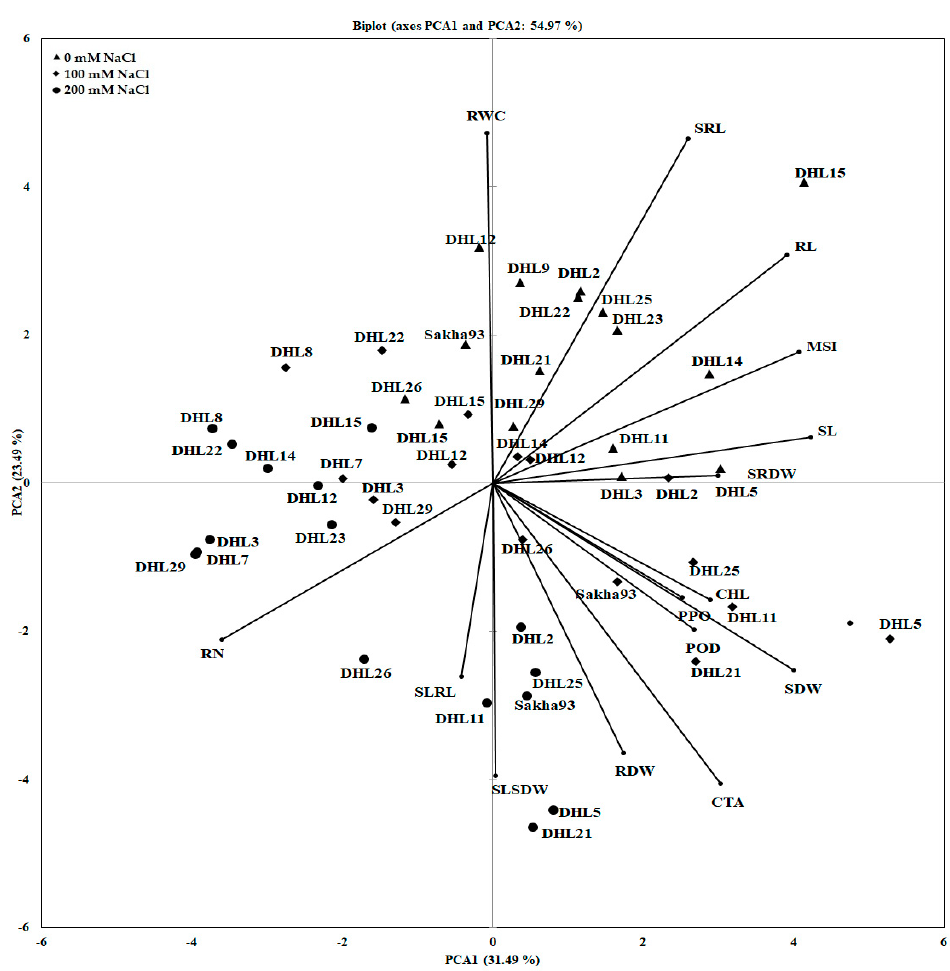
Figure 1. Principal components analysis (based on correlation matrix) of 16 wheat genotypes at three salinity levels. Biplot vectors are trait factor loadings for PC1 and PC2 of 15 measured traits. Doubled haploid line (DHL), roots number (RN), root length (RL), root dry weight (RDW), shoot length (SL), shoot dry weight (SDW), shoot root length ratio (SLRL), shoot root dry weight ratio (SRDW), shoot length shoot dry weight ratio (SLSDW), specific root length (SRL), relative water content (RWC), membrane stability index (MSI), chlorophyll content (CHL), peroxidase (POD), polyphenol oxidase (PPO), and catalase (CAT).